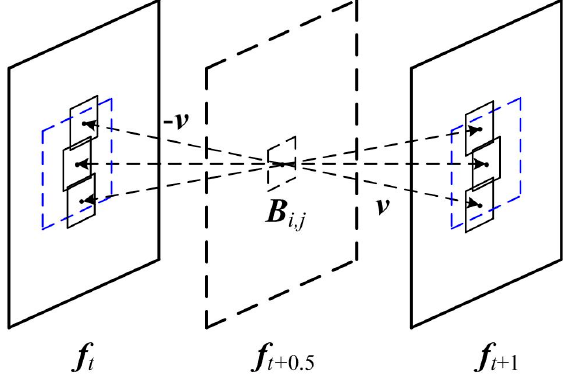
Figure 3. An illustration of a full search ME.